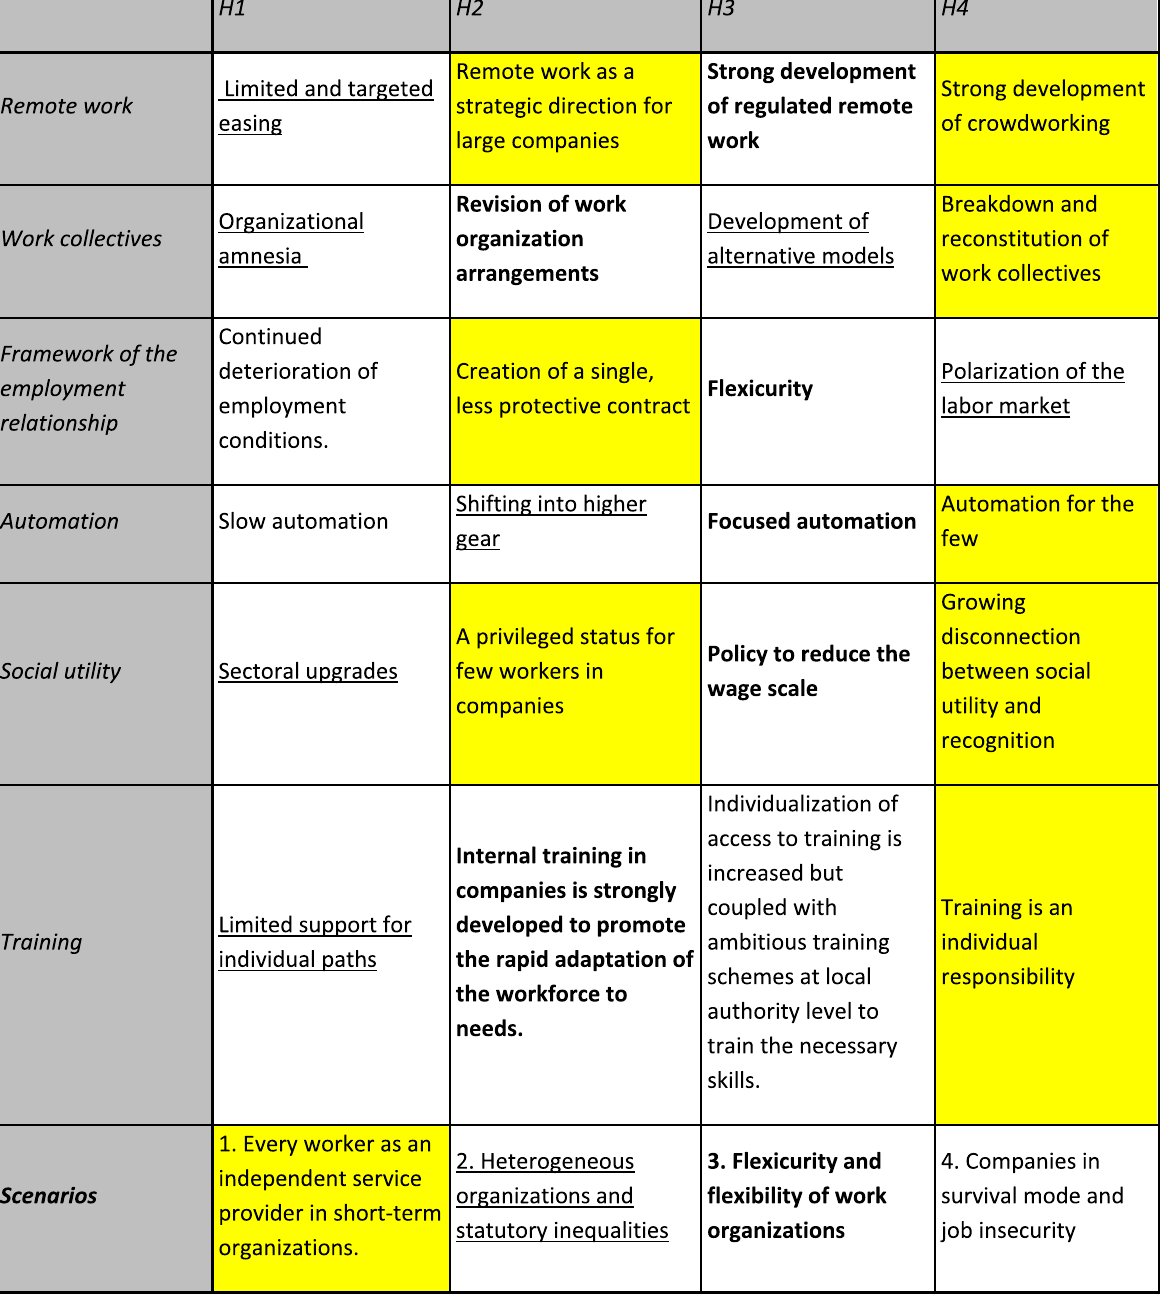
Table 2 Construction of scenarios by combining